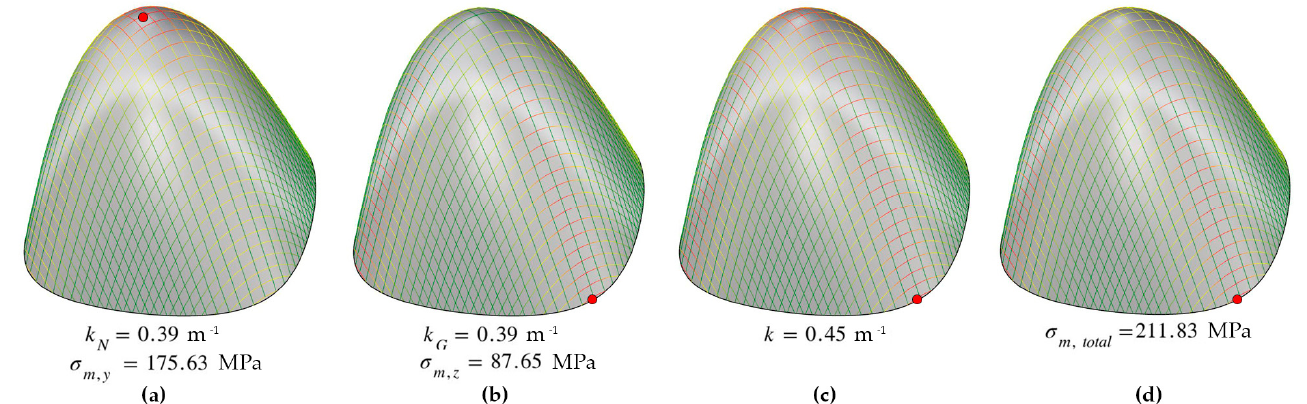
Figure 15. Evaluation of curvatures and initial bending stresses on a grid over the test surface: ( a ) Normal curvature and maximum bending stress σ m,y ; ( b ) Geodesic curvature and maximum bending stress σ m,z ; ( c ) Curvature; ( d ) Maximum total bending stress σ m,total .